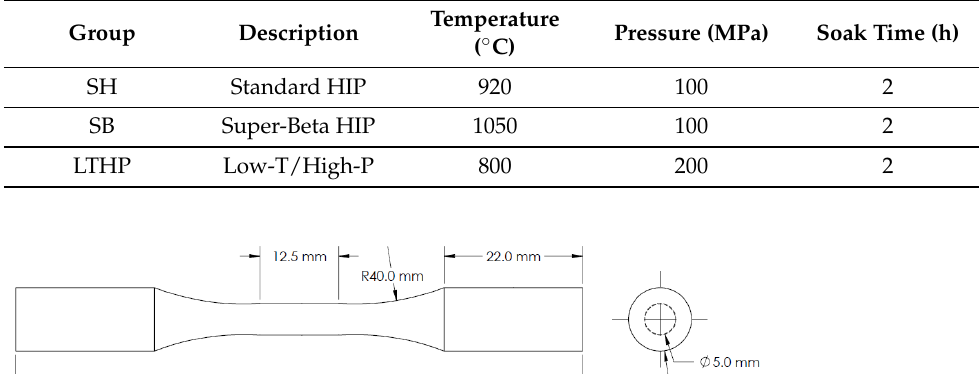
Table 2. HIP treatment parameters for each group examined in this study.